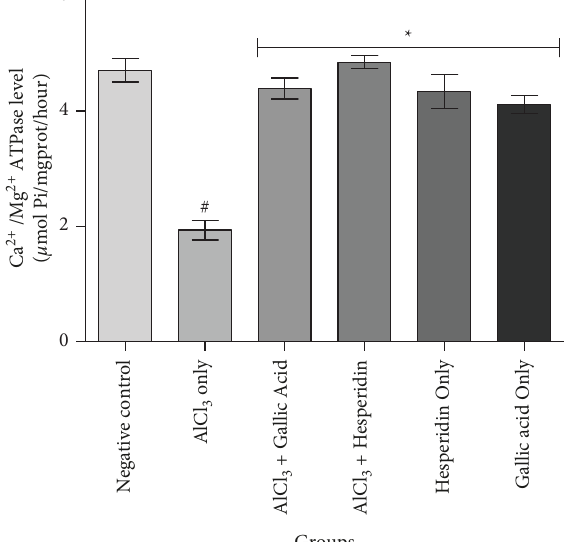
Figure 4: Effect of gallic acid and hesperidin on the serum calcium level in AlCl 3 -induced nephrotoxicity in Wistar rats. Values are expressed as the mean ± standard deviation of six determinations. # p < 0 . 05 vs negative control, ∗ p < 0 . 05 vs. AlCl 3